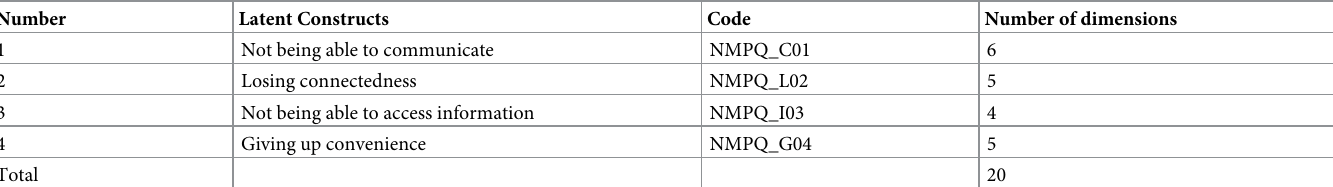
Table 2. The constructs of the NMP-Q scale and corresponding number of